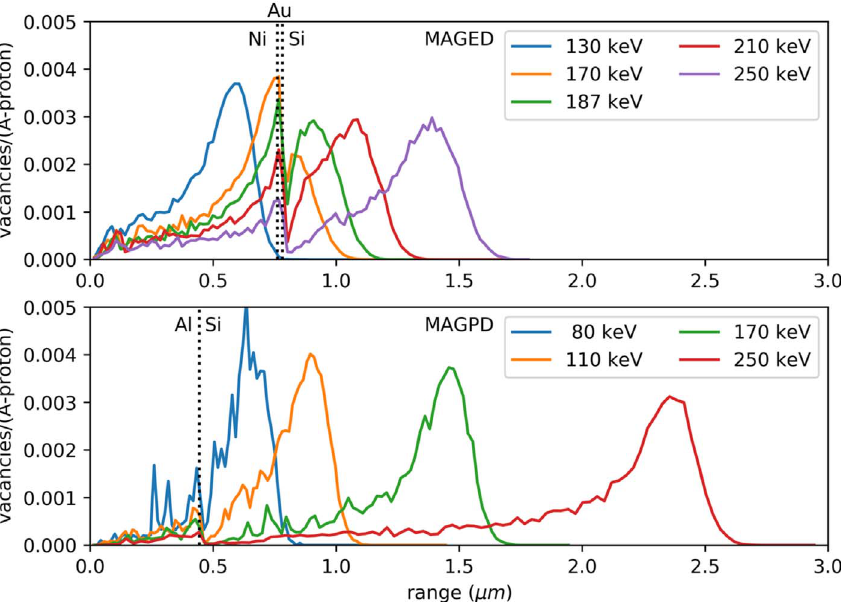
Fig. 12. Vacancies per unit depth per proton created by protons of selected proton energies in the front ends of the MAGED and MAGPD telescopes, simulated using the TRIM Monte Carlo model. For details, see the